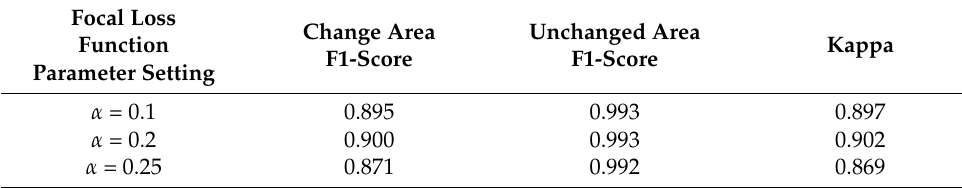
Table 1. The value of α when γ =